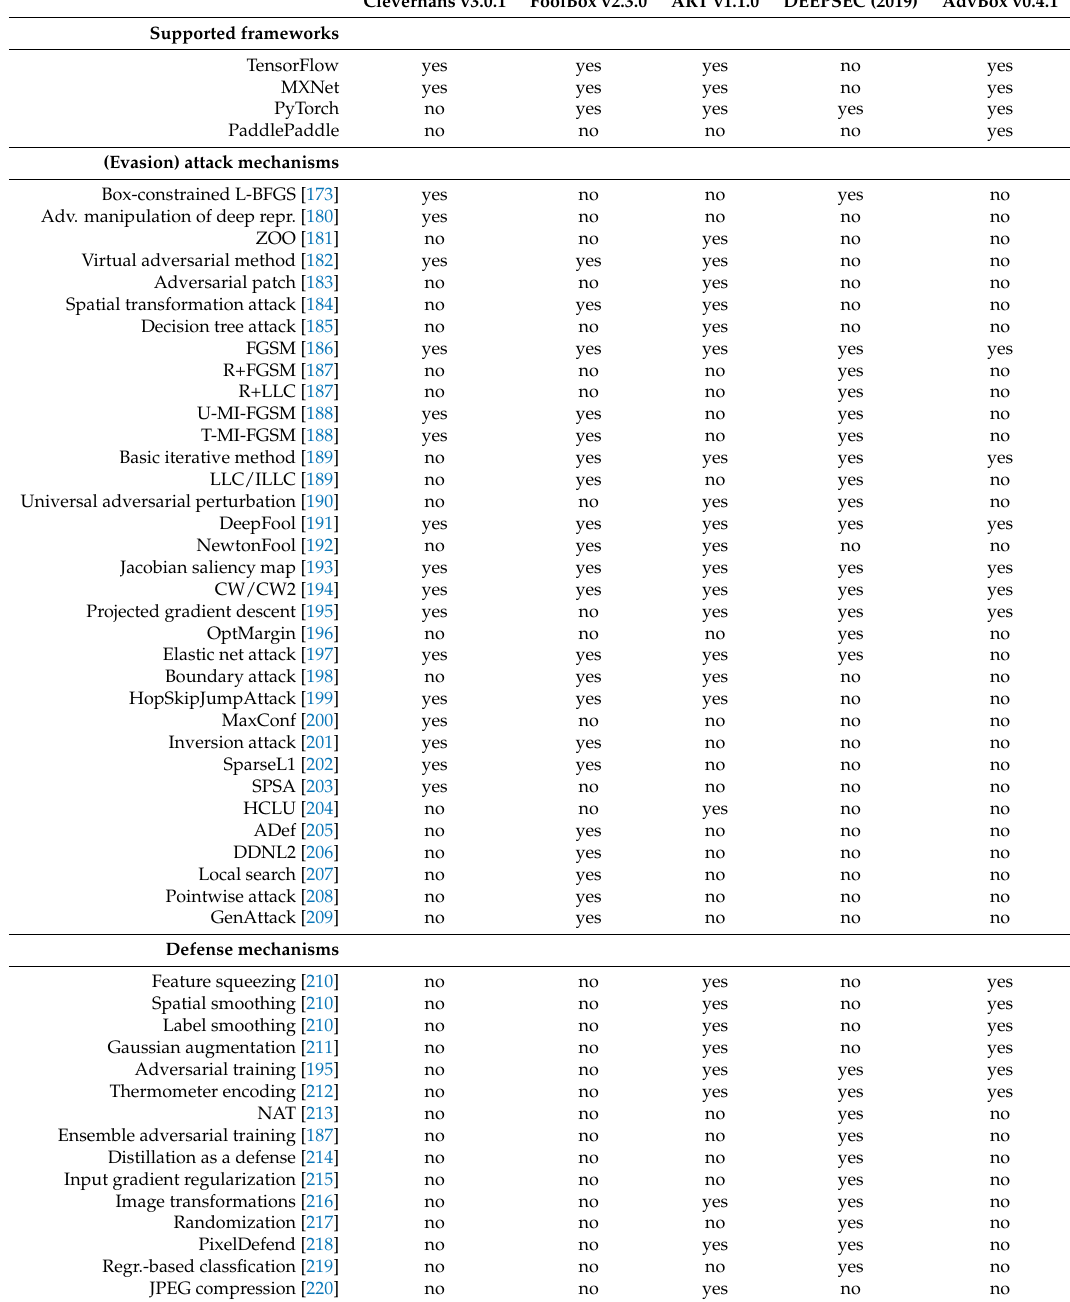
Table 1. Selection of evasion attack and defense mechanisms that are implemented in adversarial learning toolkits. Note that ART also implements methods for poisoning and extraction attacks (not